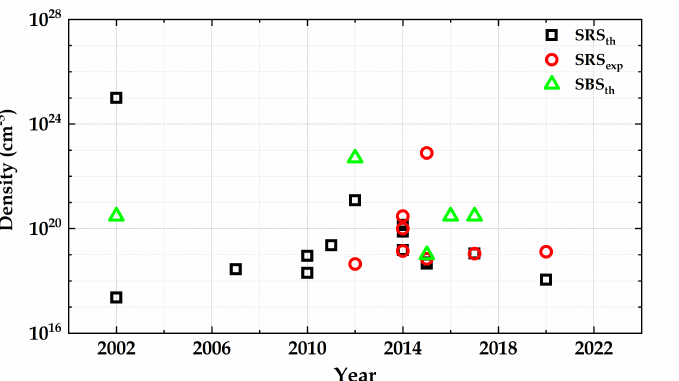
Figure 6. Density of the plasma predicted/obtained with time from 2000 to 2022 for Raman amplifi- cation and Brillouin amplification are presented